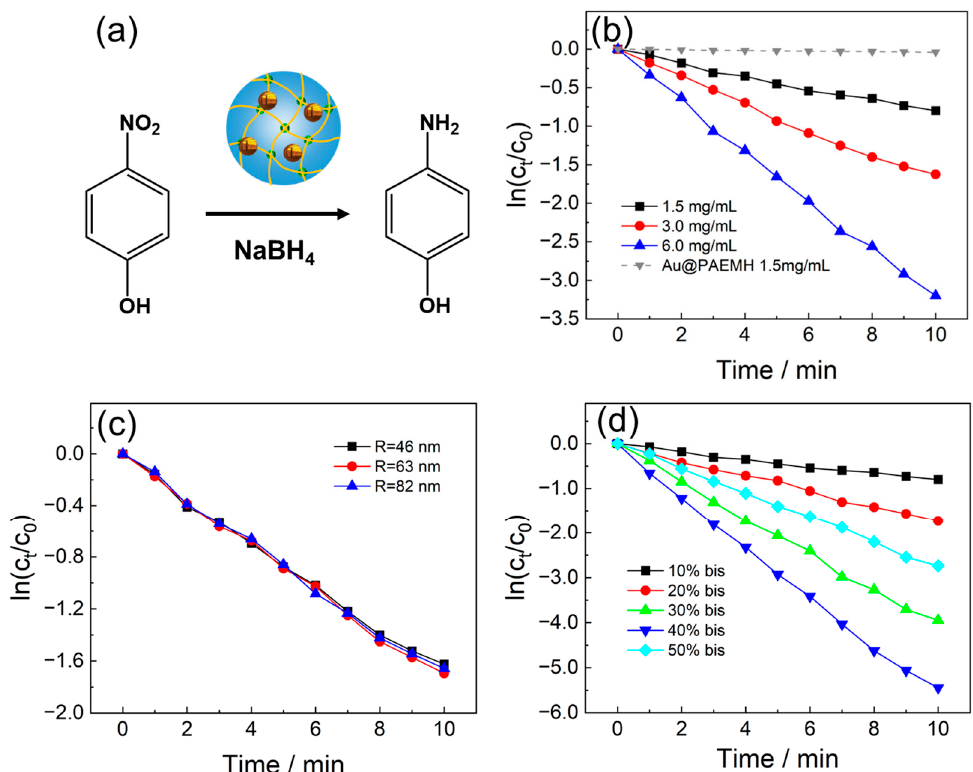
Figure 4. ( a ) Reduction of 4-nitrophenol (4-NP) to 4-aminophenol catalyzed by Au@PMETAC nanogel. ( b ) Comparison of ln(c t/ c 0 ) vs. time for reduction of 4-NP catalyzed by Au@PMETAC at di ff erent nanogel concentrations and Au@PAEMH nanogel. Comparison of ln(c t/ c 0 ) vs. time for reduction of 4-NP catalyzed by Au@PMETAC with PMETAC nanogel prepared at di ff erent sizes ( c ) and cross-